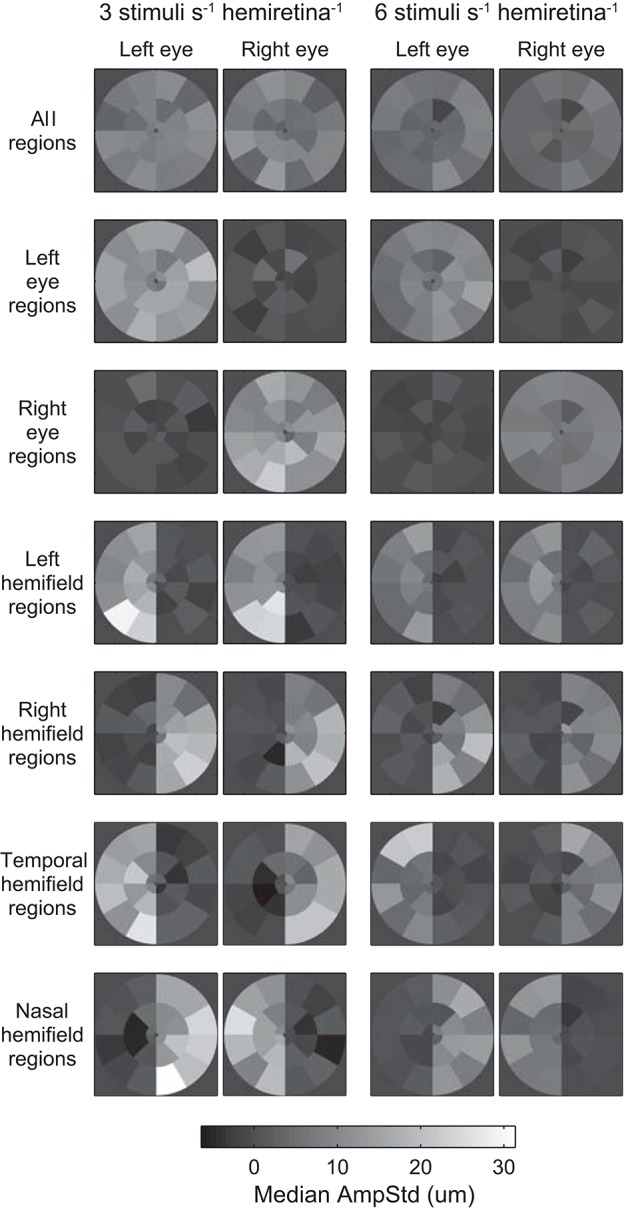
Median standardized constriction amplitudes (AmpStd) across pupils and subjects for each test-region and eye of each of the 14 stimulus variants. The rows of Table 1 correspond to the rows here.